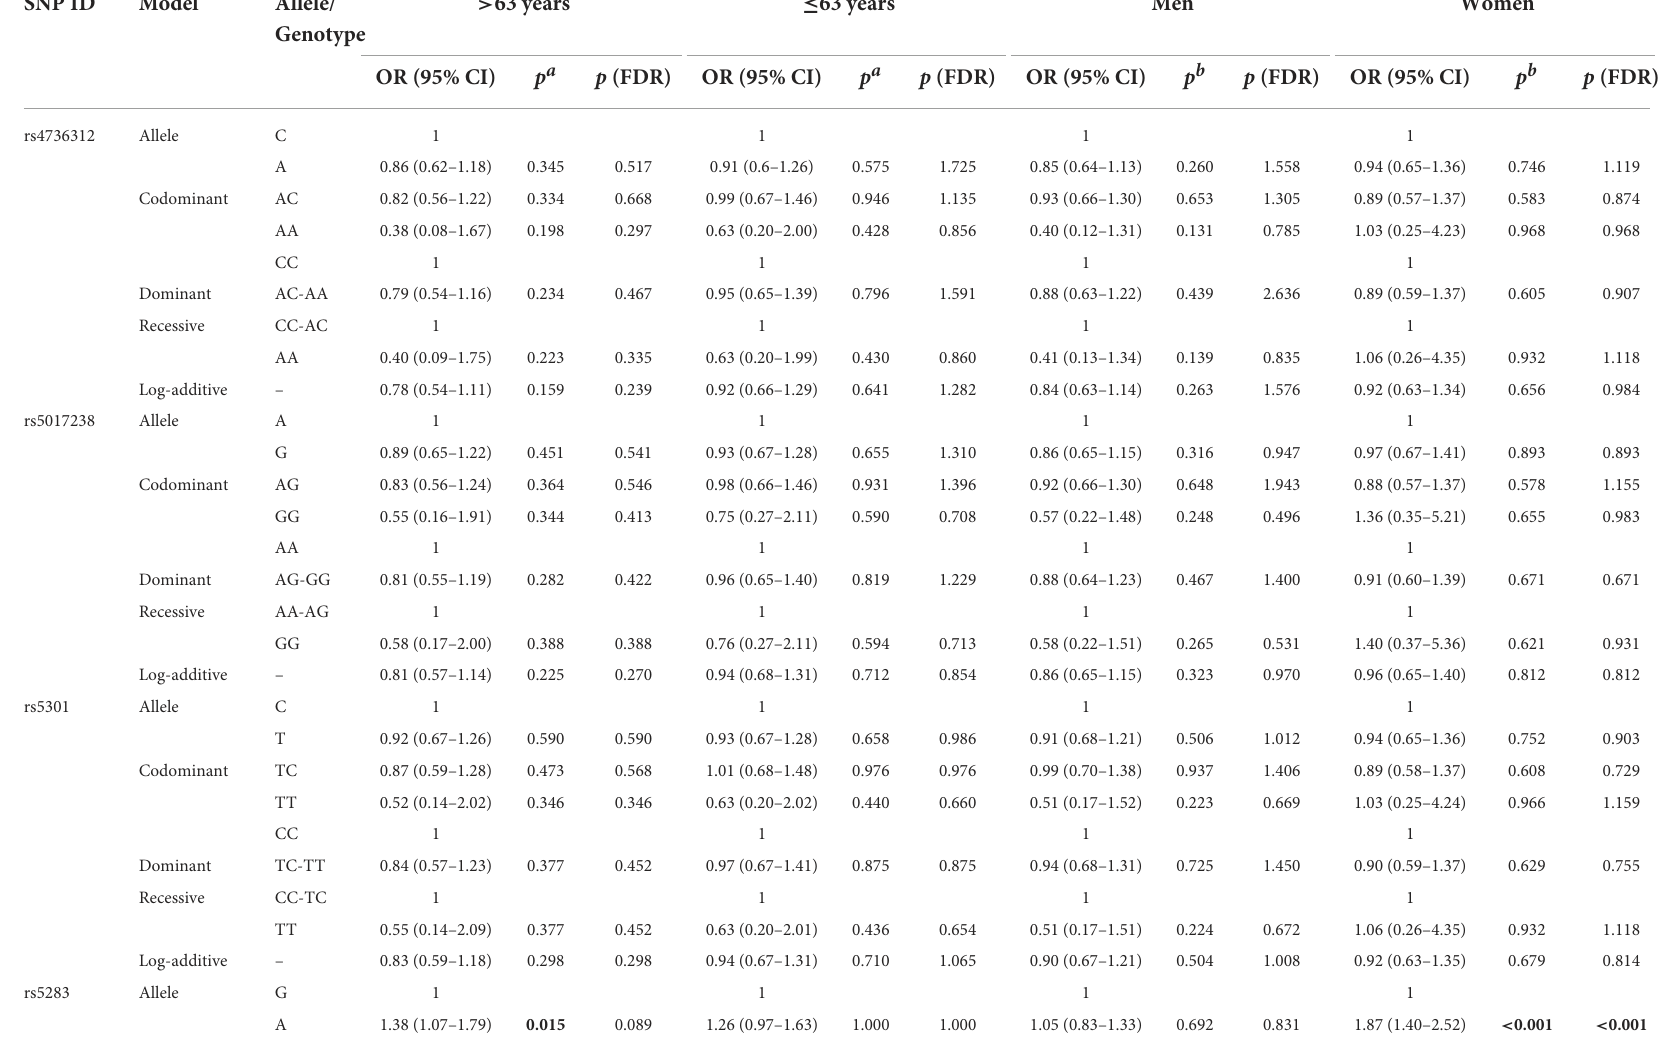
TABLE 4 Correlation of CYP11B1 polymorphisms and ischemic stroke susceptibility stratified by age and